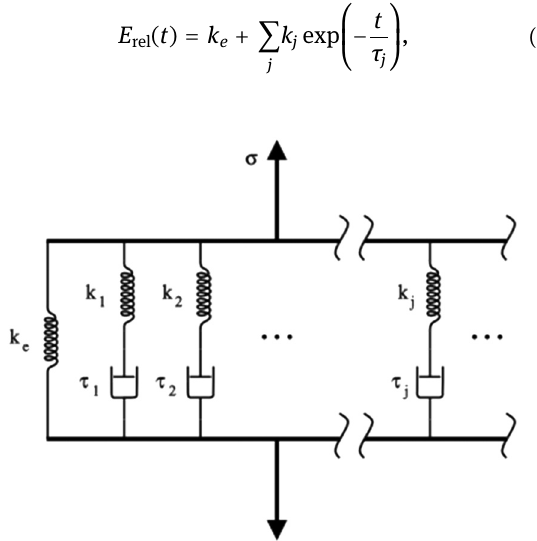
Figure 1: The Wiechert